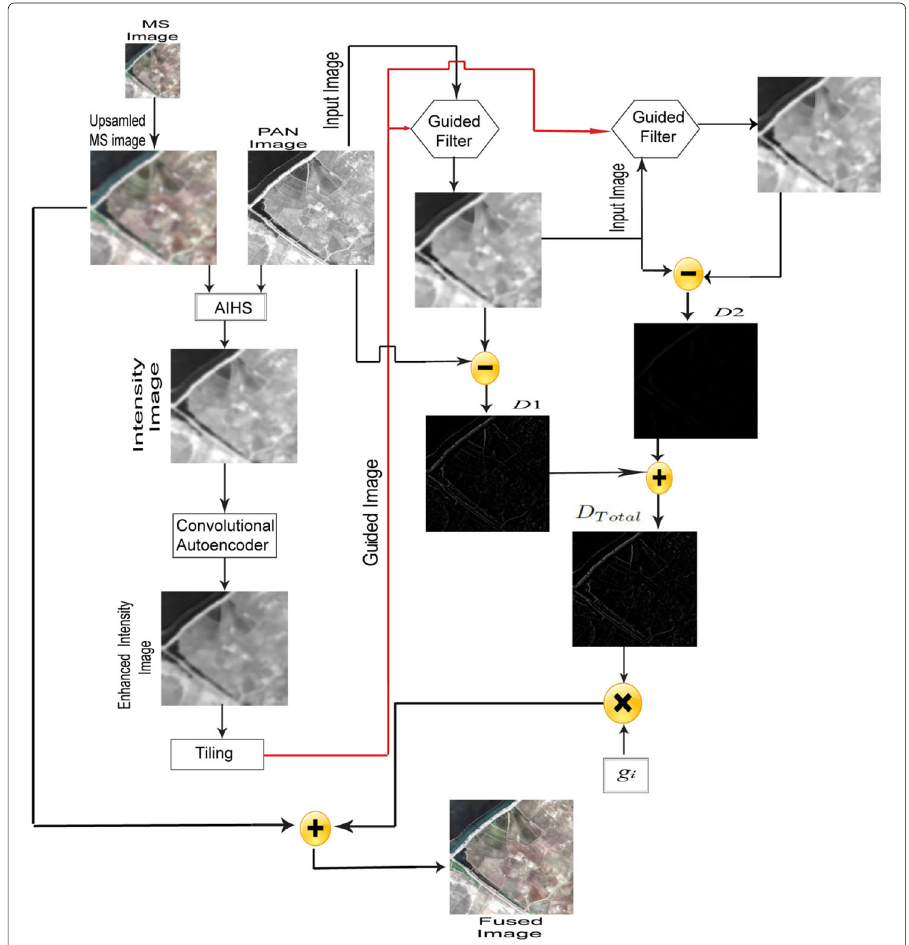
Fig. 1 The proposed methodology schematic. D represents the detailed map, and g represents the injection gain